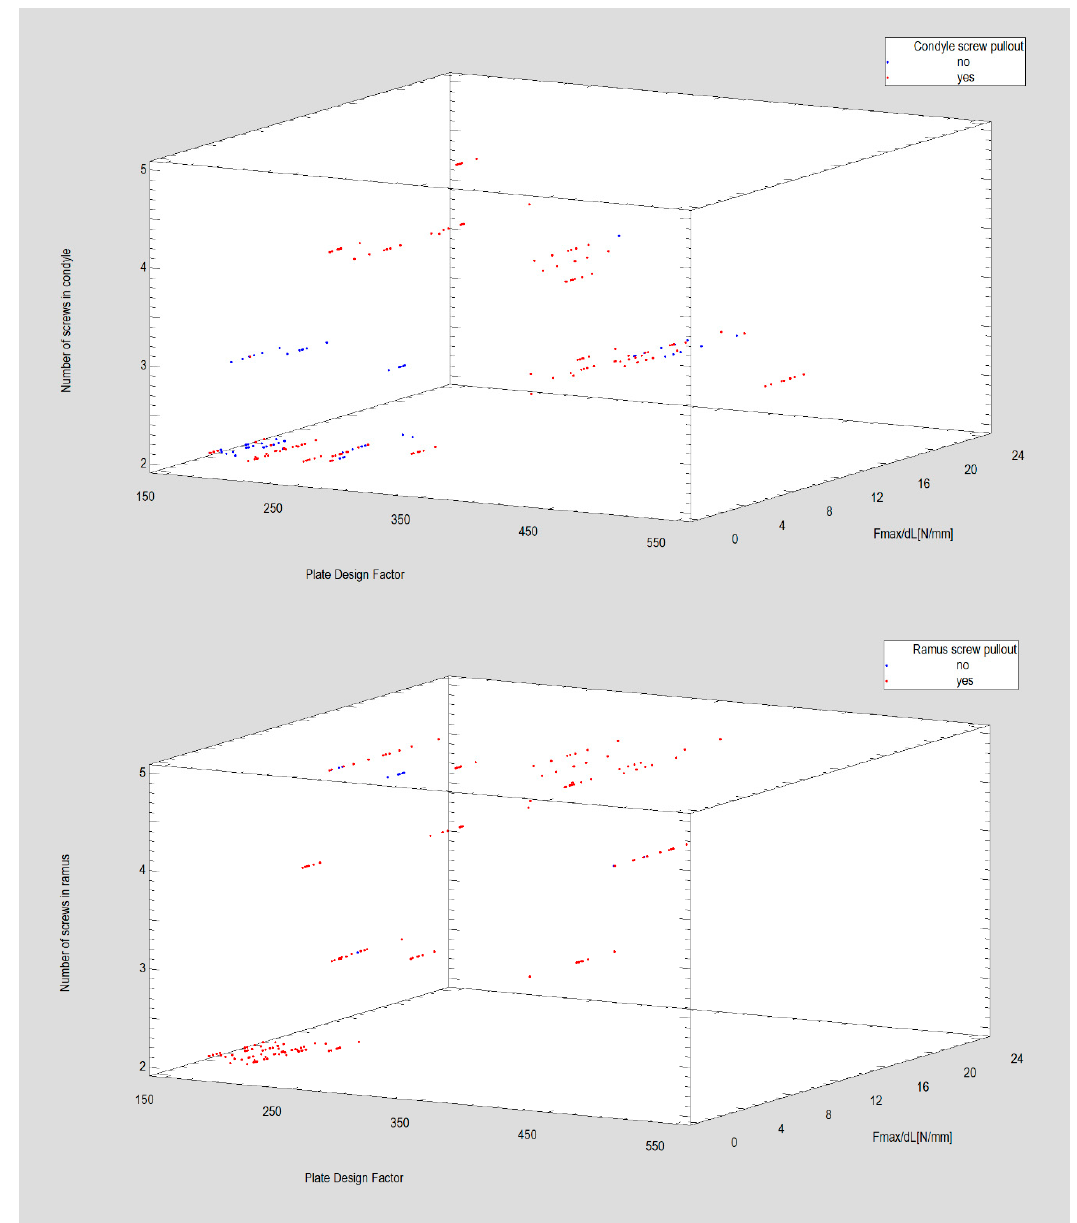
Figure 6. PNN procedure revealed that the incidents of condyle fragment screw loss are seldom predicted as Plate Design Factor is over 350 (plate 10, plate 13, plate 22, plate 23) in relatively high resistance to displacing forces (especially as 4 screws is fixing the plate in proximal fragment). But also, lower values (below 300) of Plate Design Factor (PDF) can predict stable plates fixed by only 2 screws in proximal fragment. Unfortunately, resistance to displacing forces in case of those plates is low. In ramus (distal fragment), the 2 screw fixational ways predicted failure, as far as pull out ramus screws parameter is considered. The best design is the plate 10 (Table 1) i.e. resistant to displacing force and described by Plate Design Factor (PDF) are over 450, and has 4-screw fixed in the ramus fragment. Moreover it can be noticed two designs described by Plate Design Factor as approx. 250 resistant to ramus screw pull out, but not so much resistant for displacing force unfortunately.